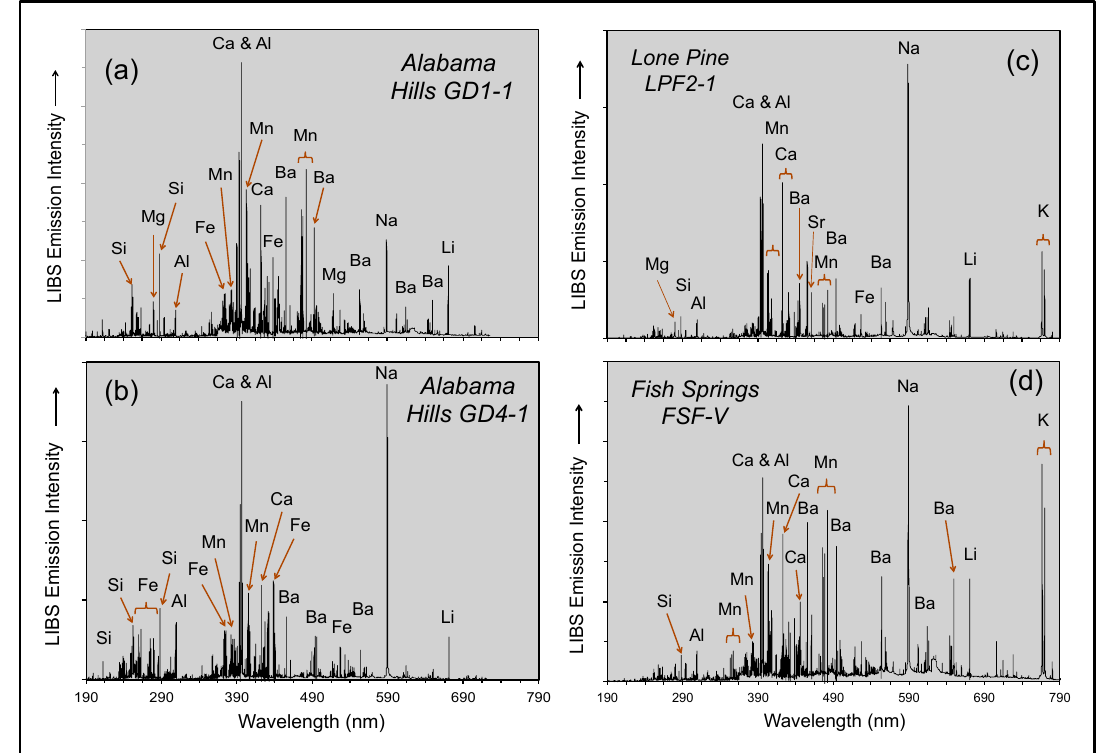
Molecules 2021 , 26 , x FOR PEER REVIEW Figure 7. LIBS spectra for rock varnish in fractures and fissures in highly weathered monzogranite at the Alabama Hills locality ( a , b ) and on large granitic boulders residing on the Lone Pine ( c ) and Fish Springs ( d ) alluvial fans.